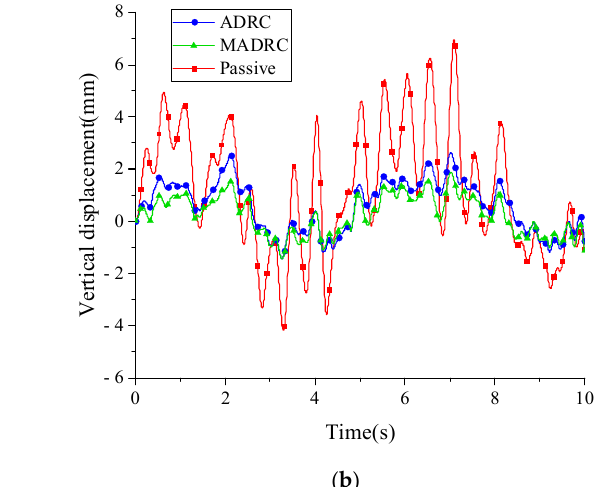
Figure 5. ( a ) Spray flow curve; ( b ) comparison curve of vehicle vertical displacement under stochastic signals.